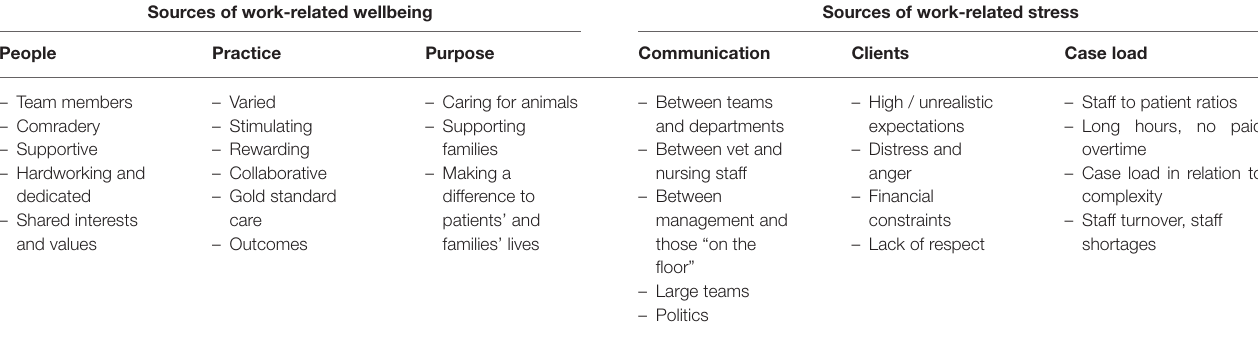
TABLE 6 | Summary of themes with